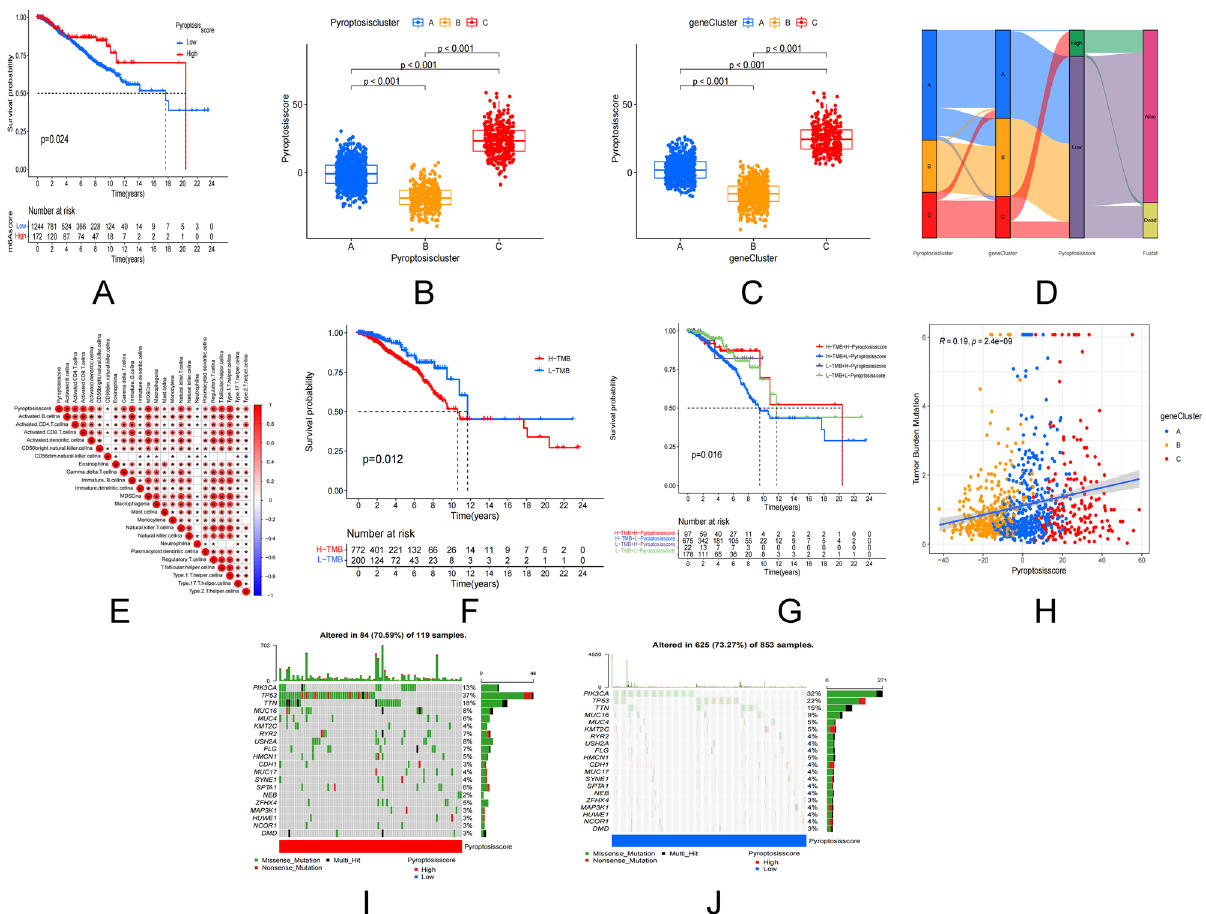
Figure 4. Construction of the pyroptosis score. ( A ) Prognostic analysis of the pyroptosis score. ( B ) Relationship between pyroptosis score and pyroptosis subtypes. ( C ) Relationship between pyroptosis score and genotyping. ( D ) Sankey plots of different pyroptosis subtypes ( A–C ), pyroptosis genetic clustering subtypes and pyroptosis score in relation to overall survival status. ( E ) Correlation analysis of pyroptosis score with 28 immune cell types. ( F ) Prognostic analysis of TMB. ( G,H ) Prognosis and correlation between pyroptosis score and tumor mutational load. ( I,J ) Waterfall plot of somatic mutation characteristics in high and low pyroptosis scores. Each column represents an individual patient. The upper bar graph shows TMB and the numbers on the right indicate the frequency of mutations in each gene. The bar on the right shows the proportion of each mutation